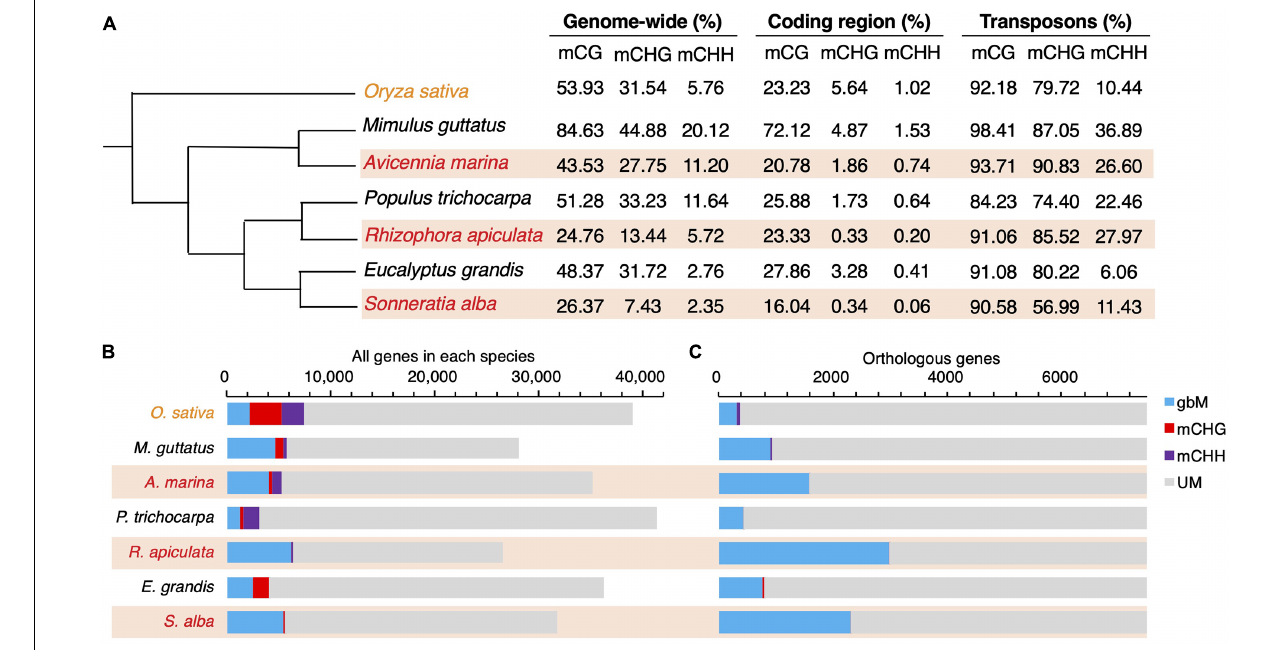
FIGURE 1 | Genome-wide methylation distribution across mangrove and non-mangrove lineages. Tree topology is adopted from Xu et al. (2017). (A) Methylation levels measured as a percentage of methylated cytosine residues genome wide or in coding regions and transposons are shown by sequence context. (B) Bar plot shows the relative abundance of BM, mCHG, mCHH (where H is A, T, or C), and UM genes genome wide or in (C) 1:1 ortholog clusters for each species. BM, genes body-methylated in the CG context; mCHG, in the CHG context; mCHH, in the CHH context; UM, unmethylated genes. Mangrove species are indicated with shadows in orange. Species are organized according to their phylogenetic